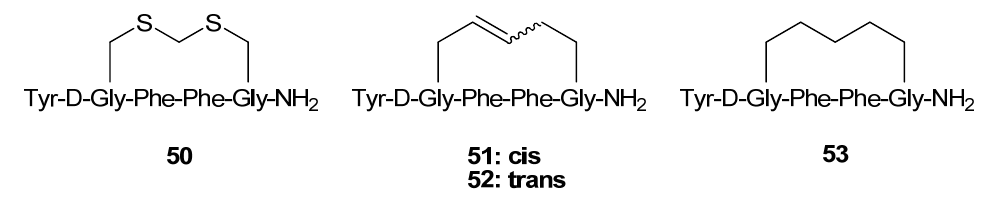
Figure 12. Replacing the dithioether linkage in 50 with a dicarba bridge leads to a reduction in potency and selectivity for opioid